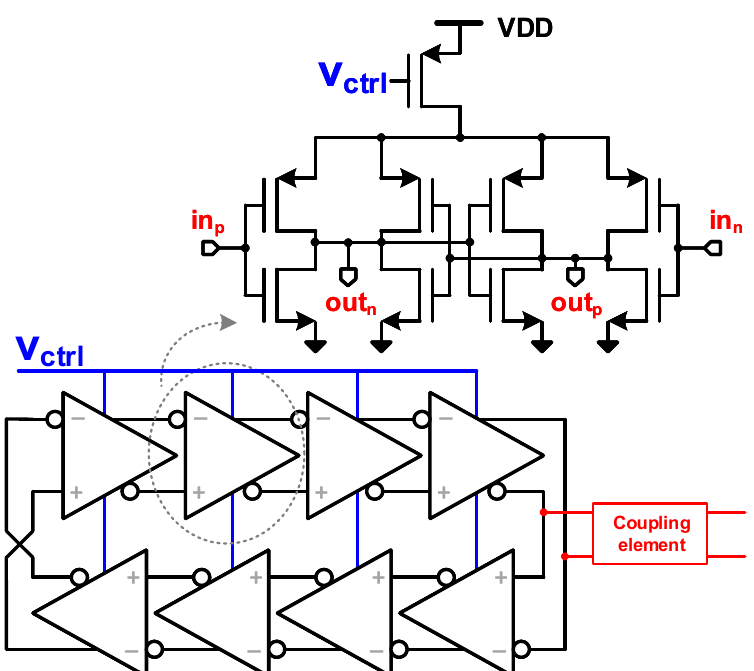
Figure 10. Current-starved 8-stage pseudo-differential RO.